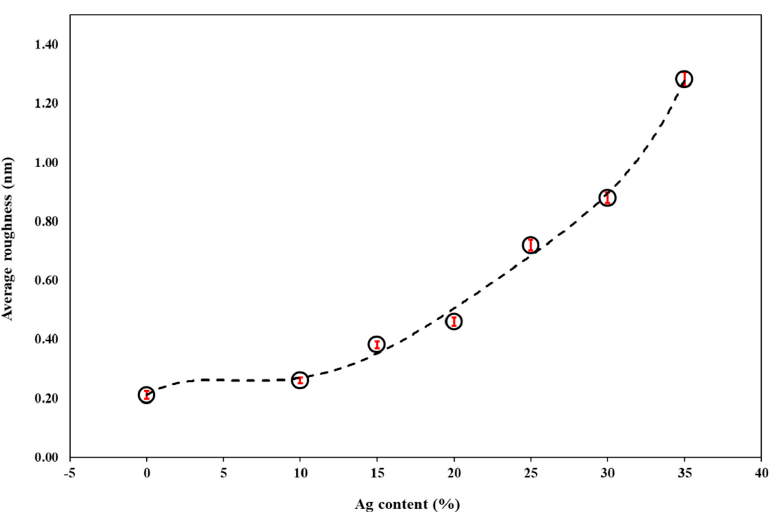
Figure 5. The average surface roughness of the Ti-Cu and Ti-Cu-Ag thin films as a function of the Ag content.